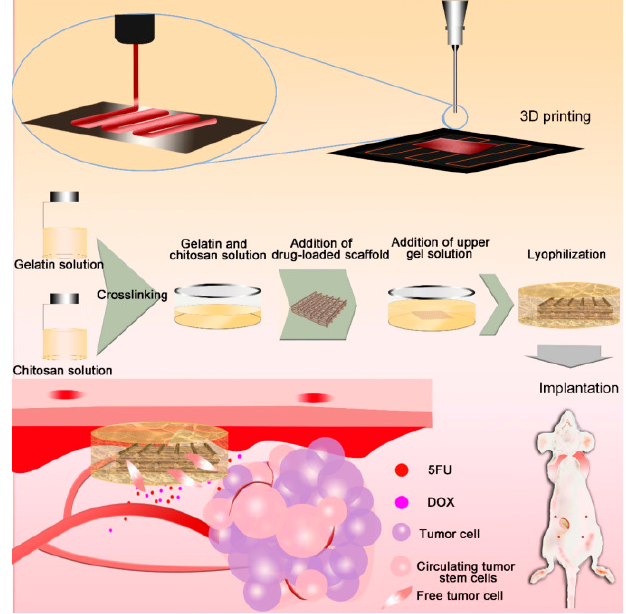
Figure 13. PLGA drug-loaded scaffolds were printed by electrohydrodynamic jet 3D printing and sandwiched in a gelatin-chitosan gel. Scaffolds were implanted in vivo to absorb hemorrhage and cell residues after surgery, and to inhibit cancer cells and circulating tumor cells. Reprinted from [162], Theranostics 2020.